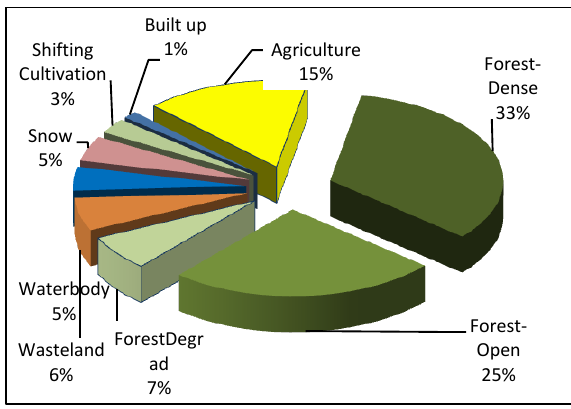
Figure 4. Major land cover classes of